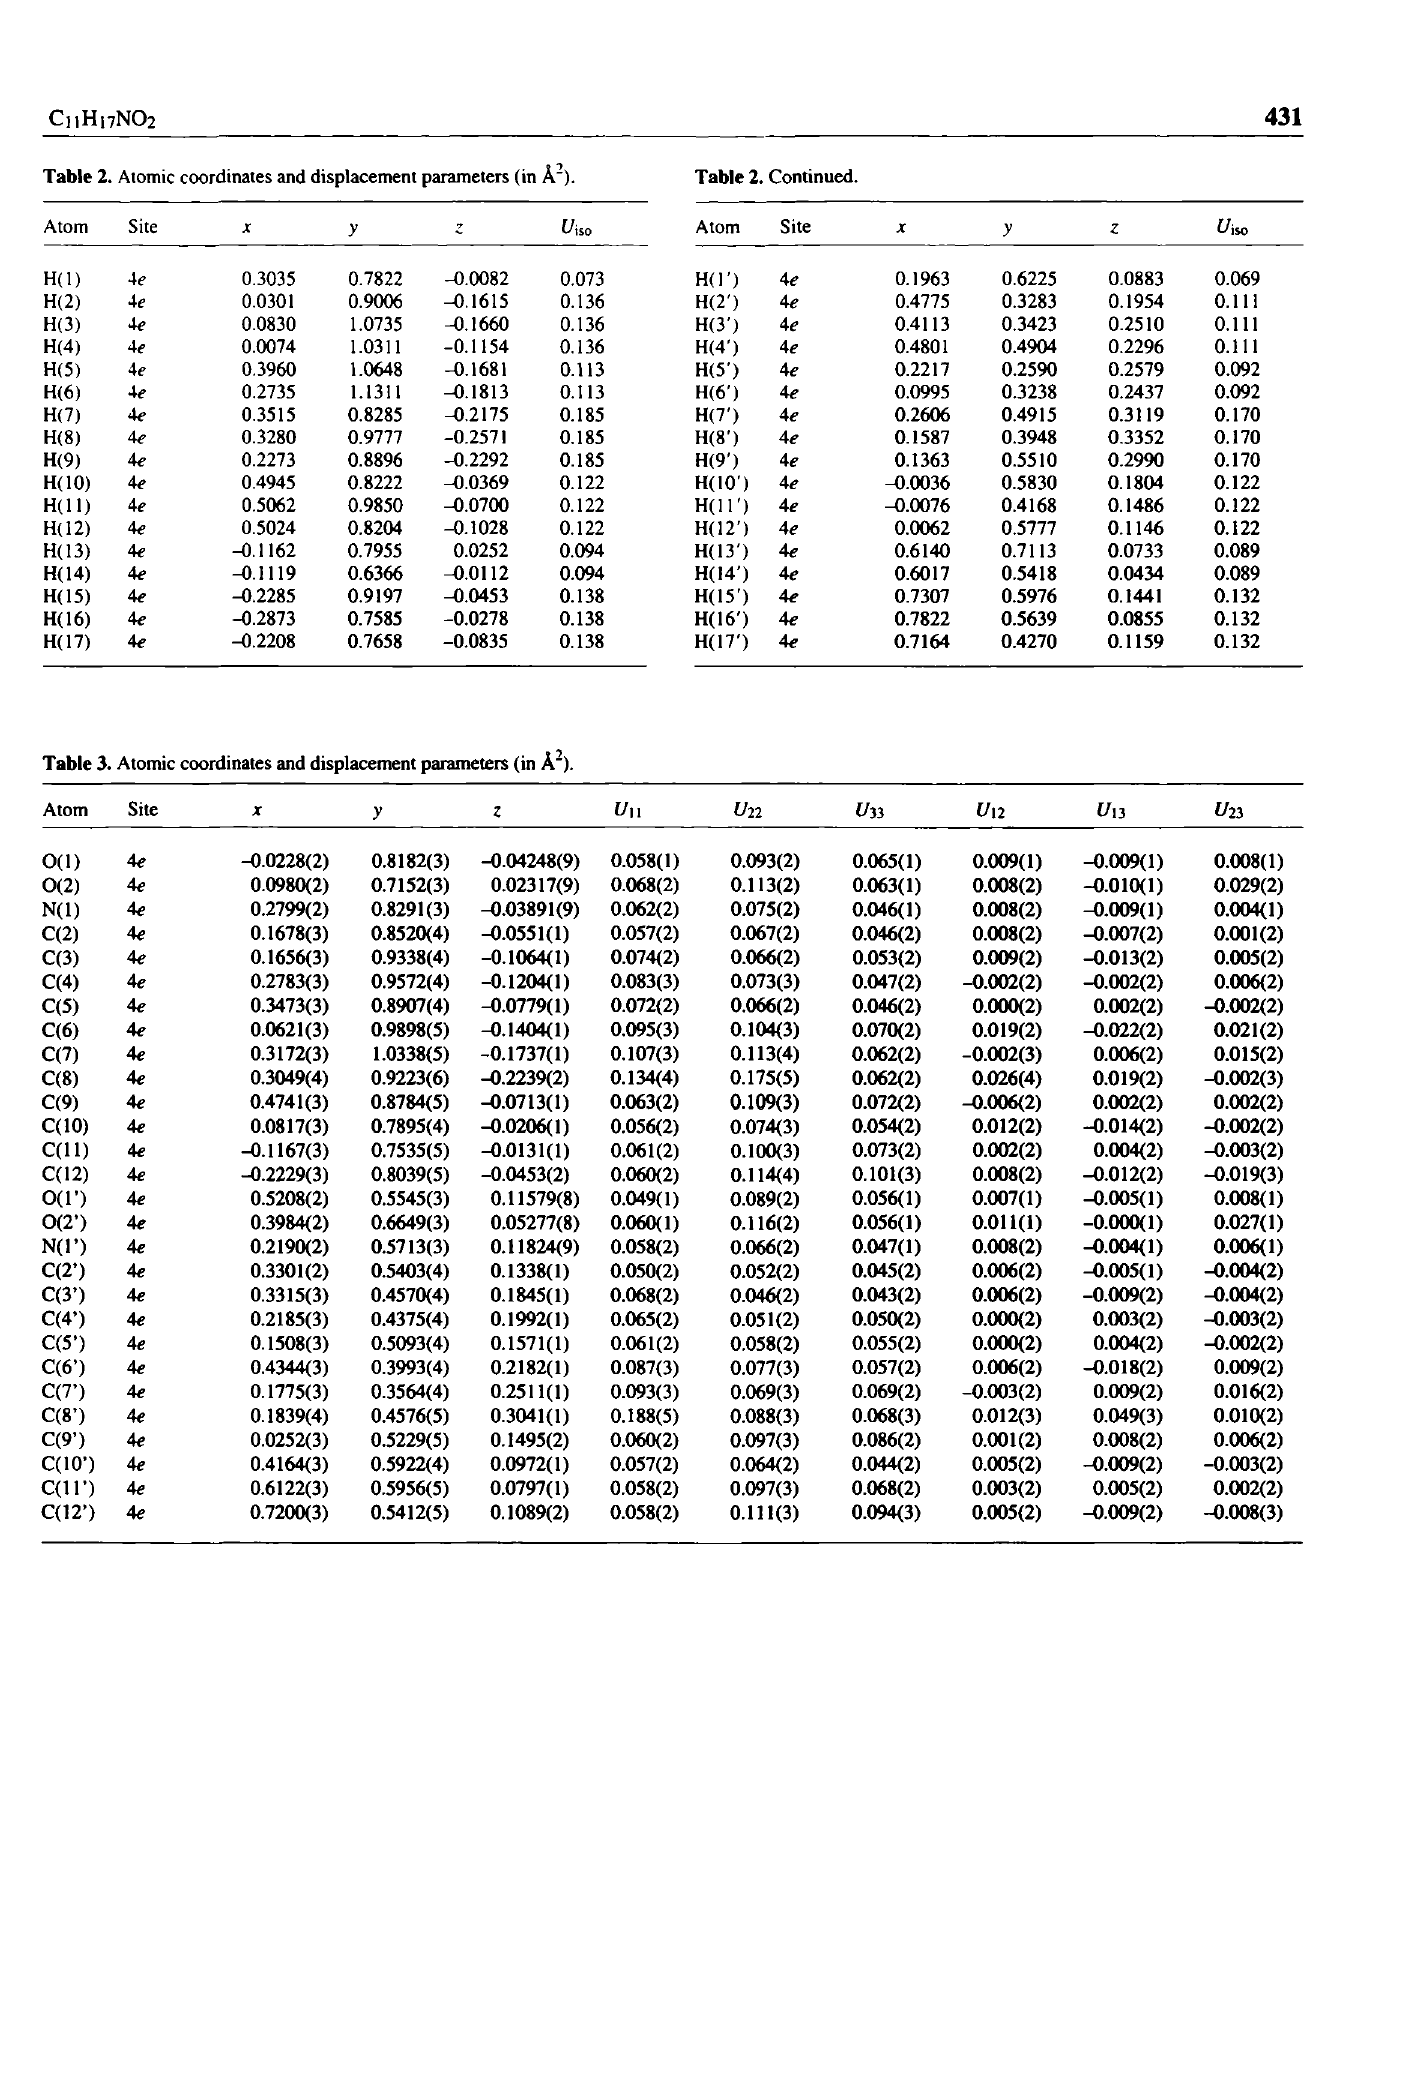
Table 3. Atomic coordinates and displacement parameters (in À 2